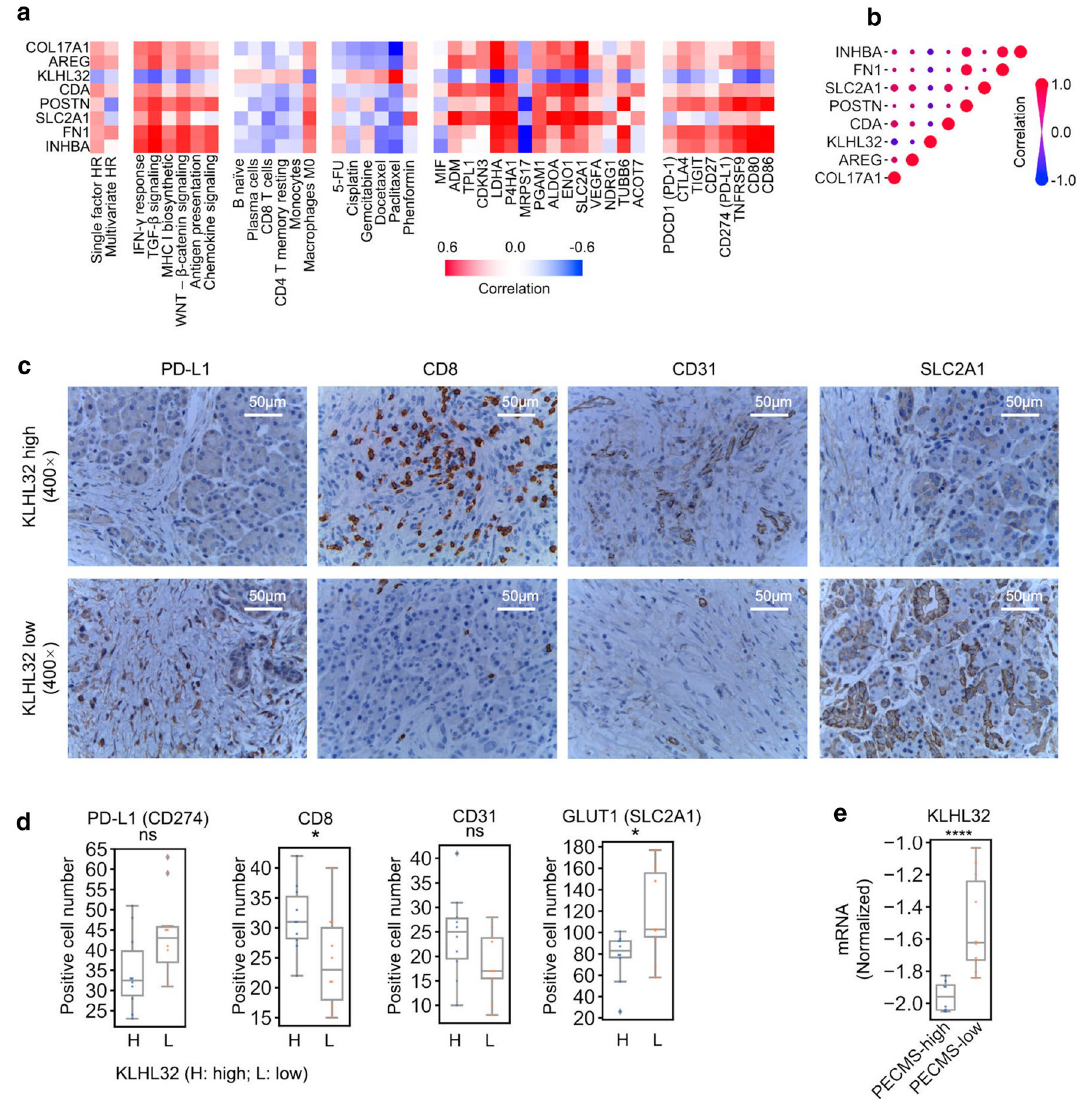
Fig. 5 Relationship between KLHL32 and the pancreatic cancer ECM ( a Correlation between PECMS feature genes and immune, metabo- lism, and drug sensitivity prediction characteristics. b Internal correlation among mRNA expression of PECMS feature genes. c Representa- tive IHC images of PD-L1, CD8, CD31, and SLC2A1 in the KLHL32-high or KLHL32-low groups. d Comparison of mean positive cell number of IHC in 10 high power fields between the KLHL32-high (H) and the KLHL32-low (L) group. e mRNA of KLHL32 in PECMS-high and PECMS-low group. ns: no significant difference; *: P <